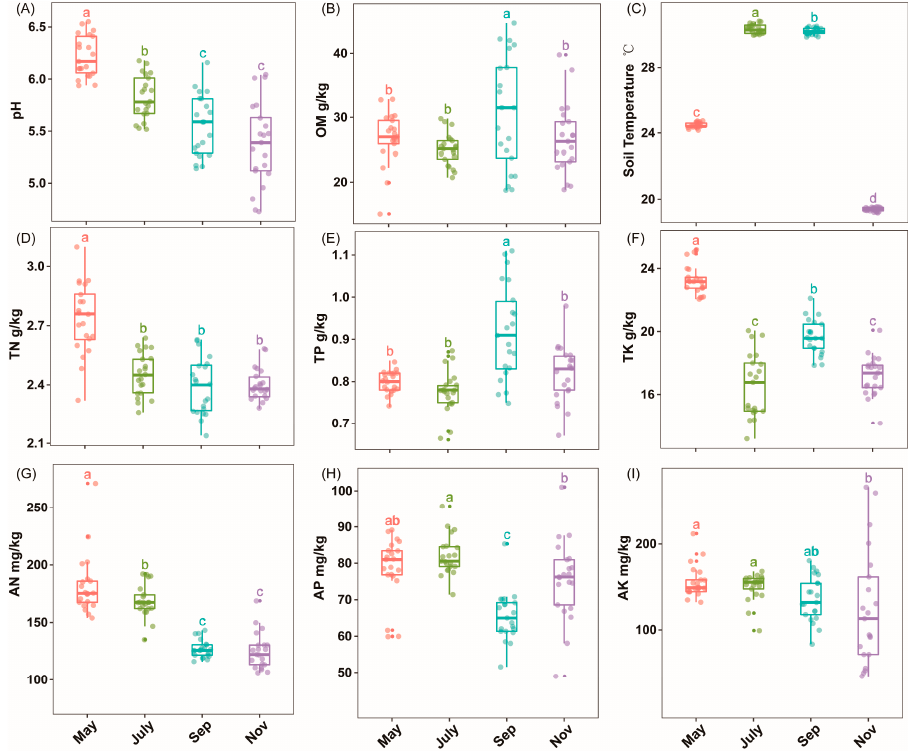
Figure 1. The box plot shows soil physiochemical property, namely, pH ( A ), OM, soil organic mat- ter ( B ); TN, total nitrogen ( D ); TP, total phosphorus ( E ); TK, total potassium ( F ); AK, available potas- sium ( G ); AP, available phosphorus ( H ); AN, available nitrogen ( I ); Tem, soil temperature collected in May, July, September and November during sugarcane seedlings, tillering, elongation and maturity stages, respectively ( C ). Different letters indicate significantly different among the different time points ( p < 0.05, ANOVA, Tukey HSD).